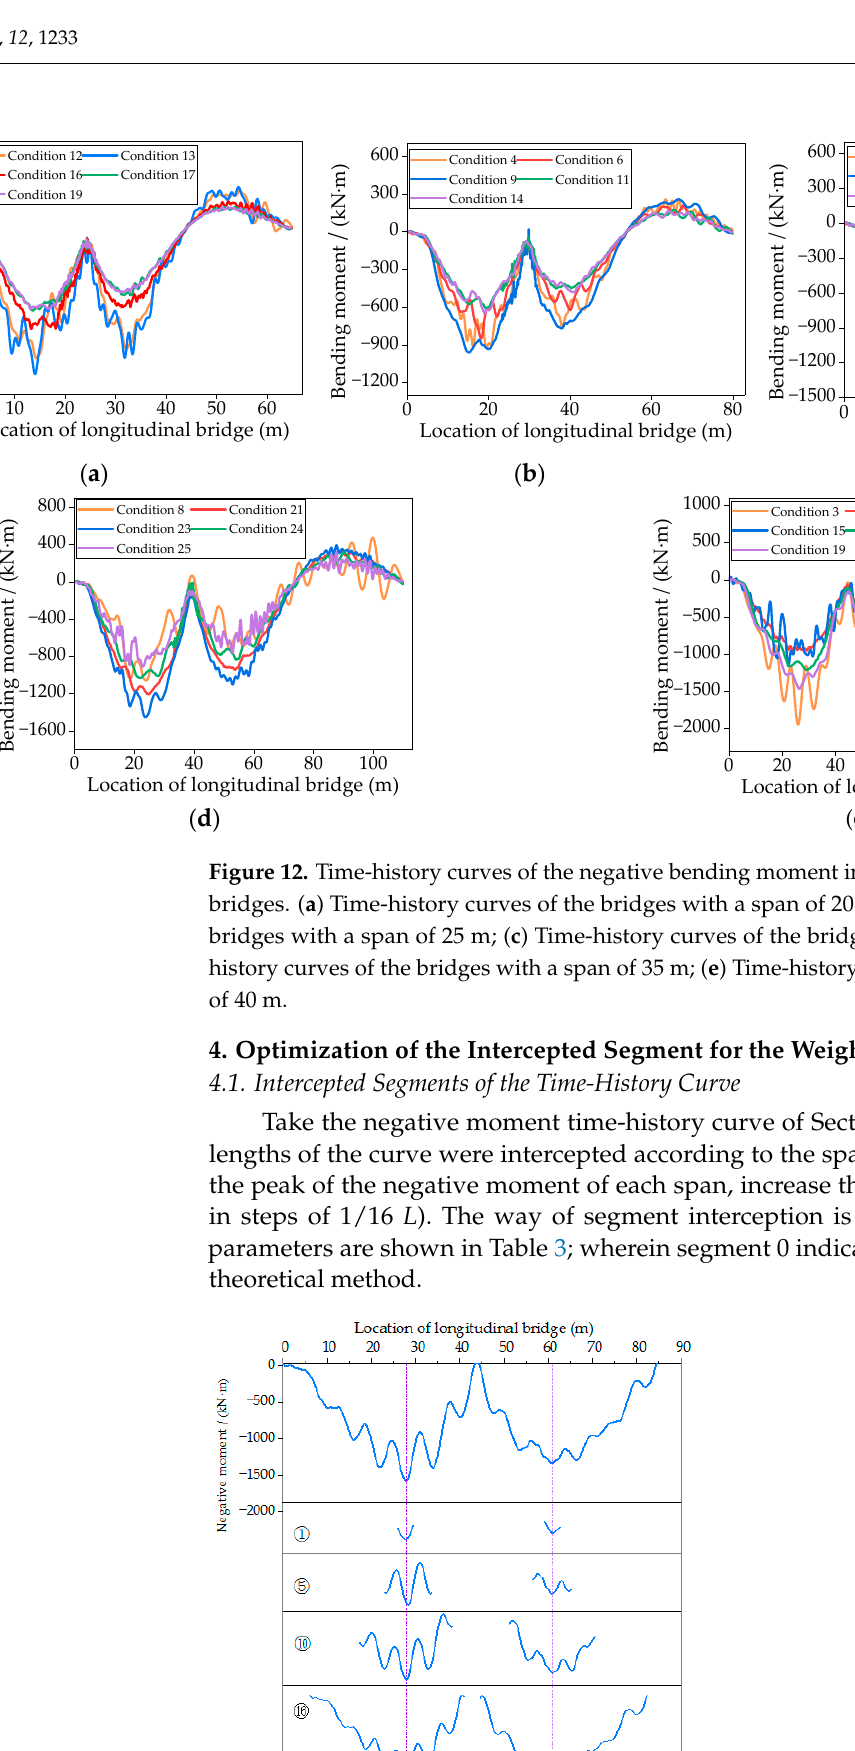
Figure 11. Time-history curves of the negative bending moment in the two-span continuous girder bridges. ( a ) Time-history curves of the bridges with a span of 20 m; ( b ) Time-history curves of the bridges with a span of 25 m; ( c ) Time-history curves of the bridges with a span of 30 m; ( d ) Time- history curves of the bridges with a span of 35 m; ( e ) Time-history curves of the bridges with a span of 40 m.